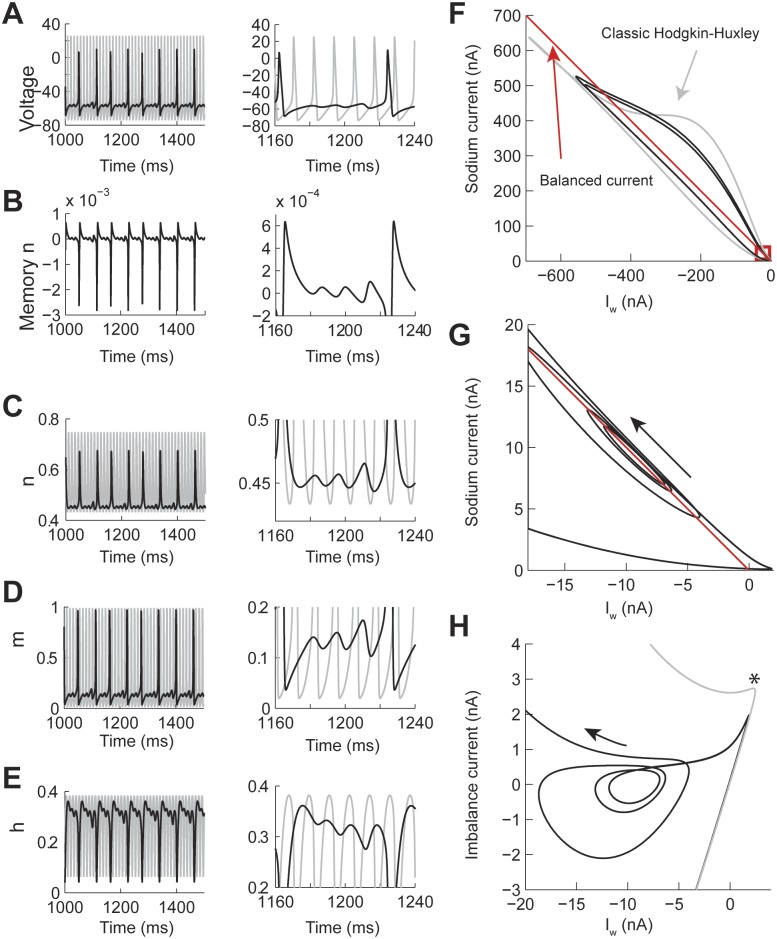
The contribution of the memory trace to Mixed Mode Oscillations in the Hodgkin-Huxley model with power-law n gate.The power-law dynamics was implemented with fractional derivative of order η = 0.7 and constant input current I = 23 nA. (A-E) Examples over a long (left) and short (right) time window of the voltage, memory trace, and gate values. The gray line is the identical simulation with η = 1.0. (F-H) Phase plane analysis of the same responses. (F) Phase plot of the sodium (INa) vs Iw = potassium + leak + injected currents. The red line indicates the balance current and the red square indicates the presence of an attractor. (G) Zoom in the attractor in F. (H) Same data as in G but plotting the imbalance current (INa+Iw) vs Iw. The * indicates where Iw starts compensating for INa.